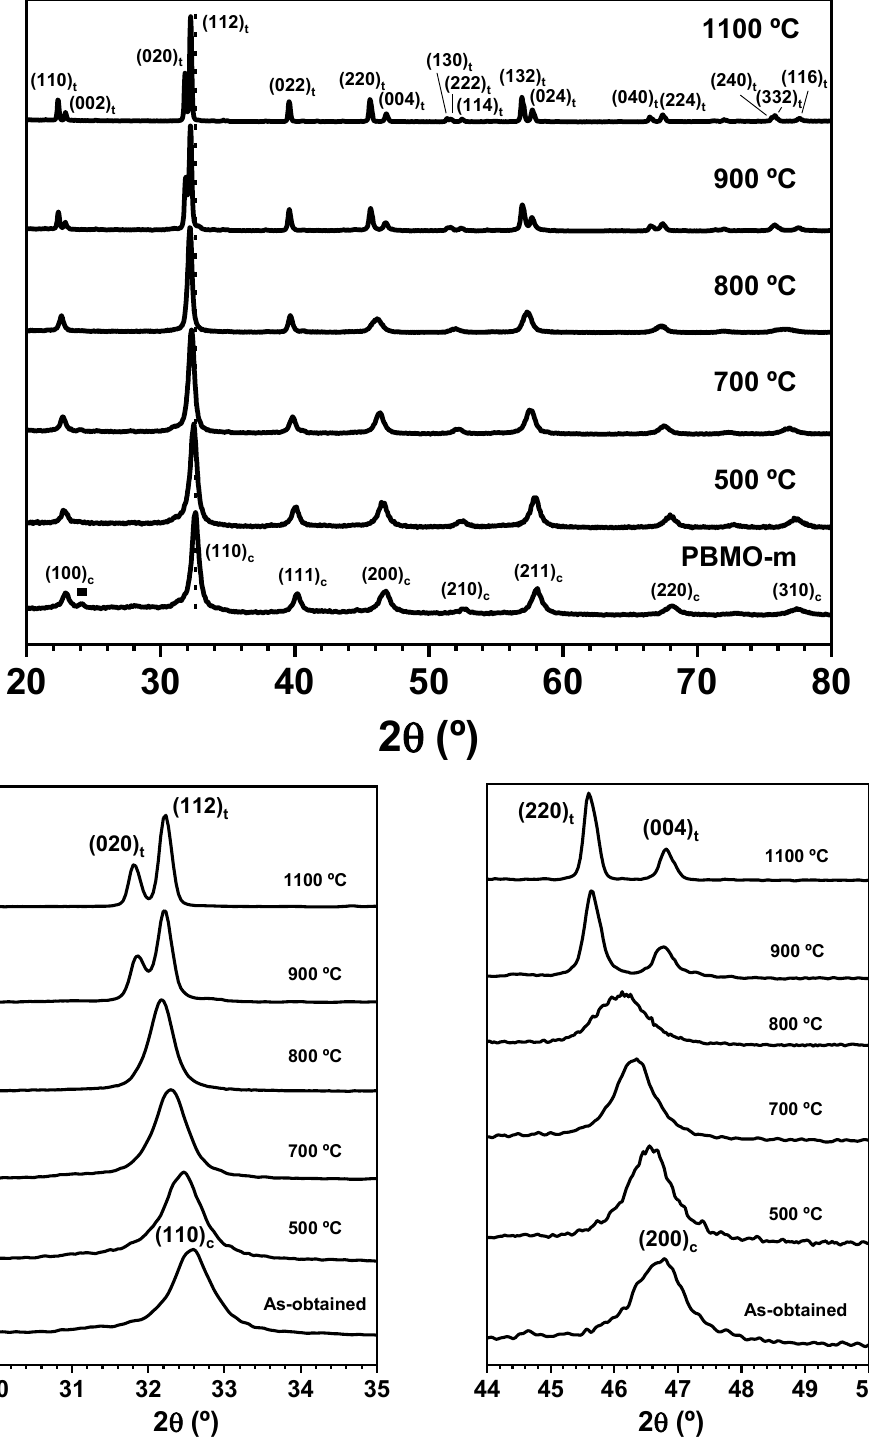
Figure 3. Room-temperature XRD patterns of PBMO-m sample after annealing for 3 h at increas- ing temperature in Ar. (  BaCO 3